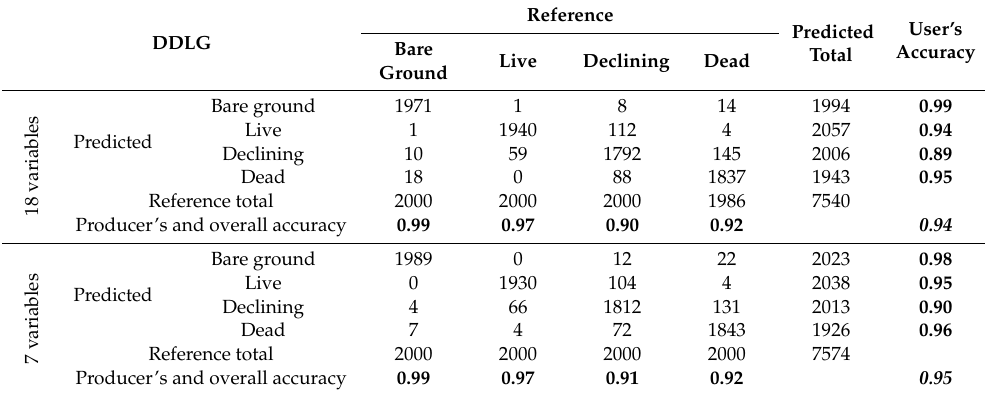
Table A1. Confusion matrix presenting the pure class validation results (confusion matrix, user’s and producer’s accuracy (in bold) and overall accuracy (in bold / italics)) of the RF model (DDLG) with (1) 18 variables versus (2) 7 variables.